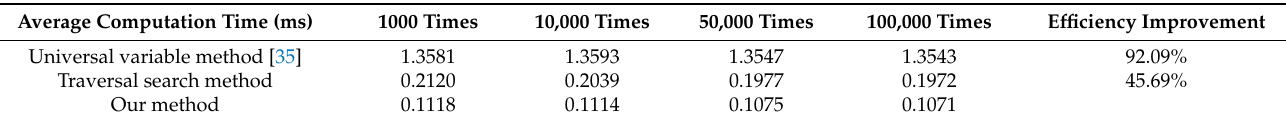
Table 1. Results for the computation time of the simulation.